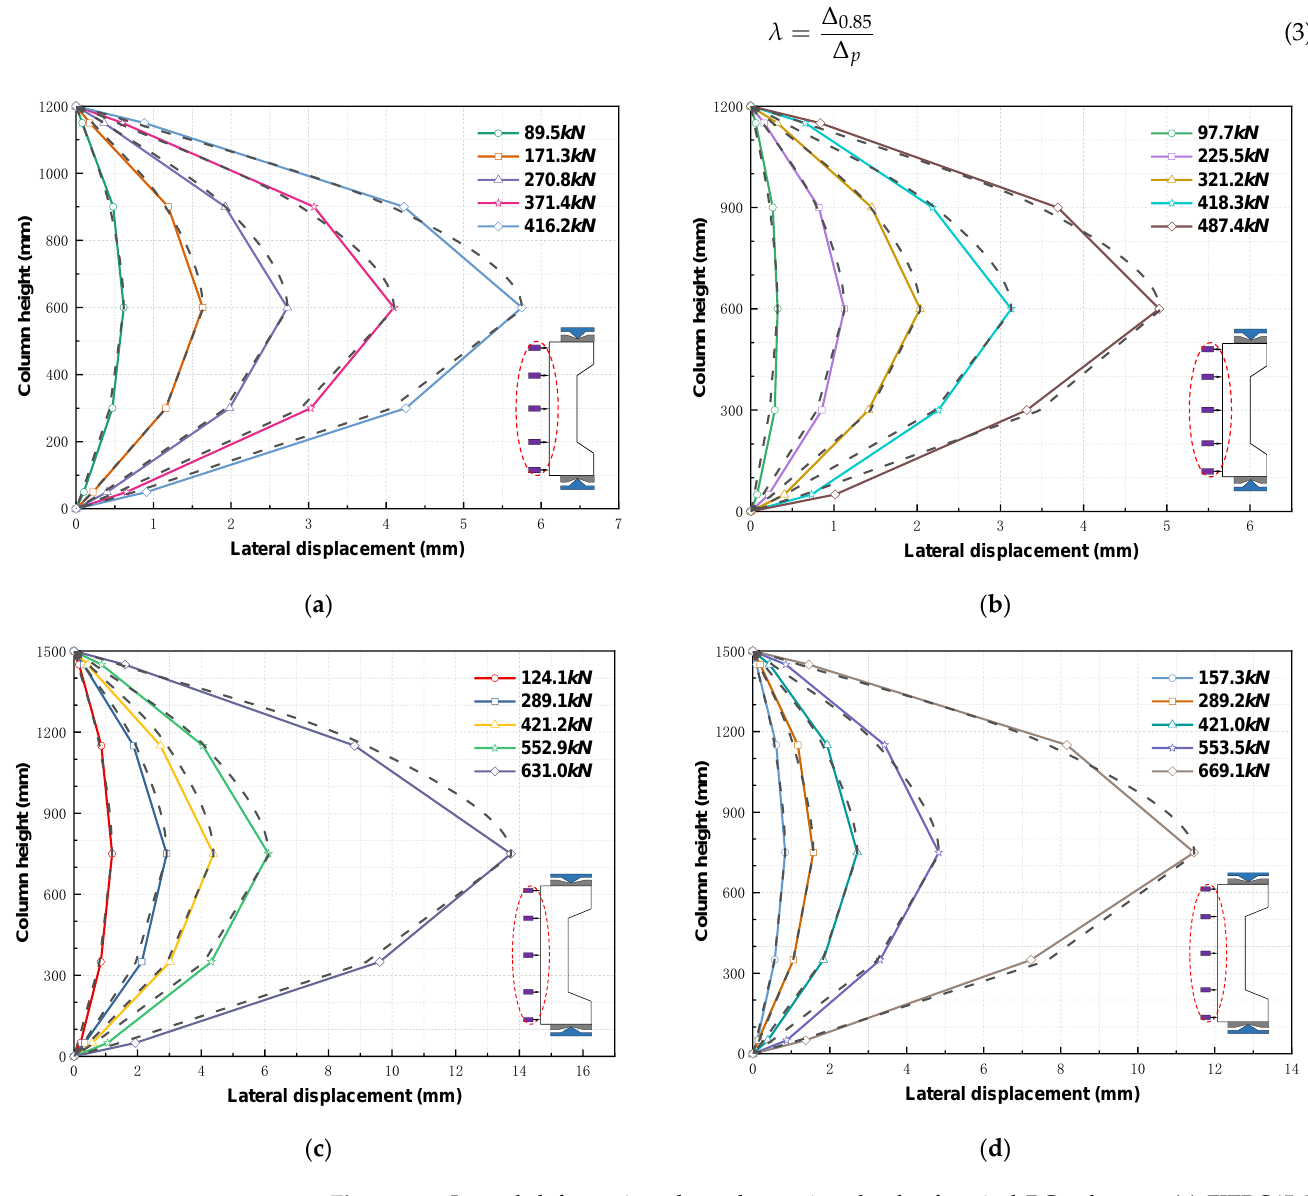
Figure 11. Lateral deformation along the section depth of typical RC columns: ( a ) FITRC45-2 column specimen; ( b ) CRC45 column specimen; ( c ) FITRC35-2 column specimen; ( d ) CRC35 column specimen.